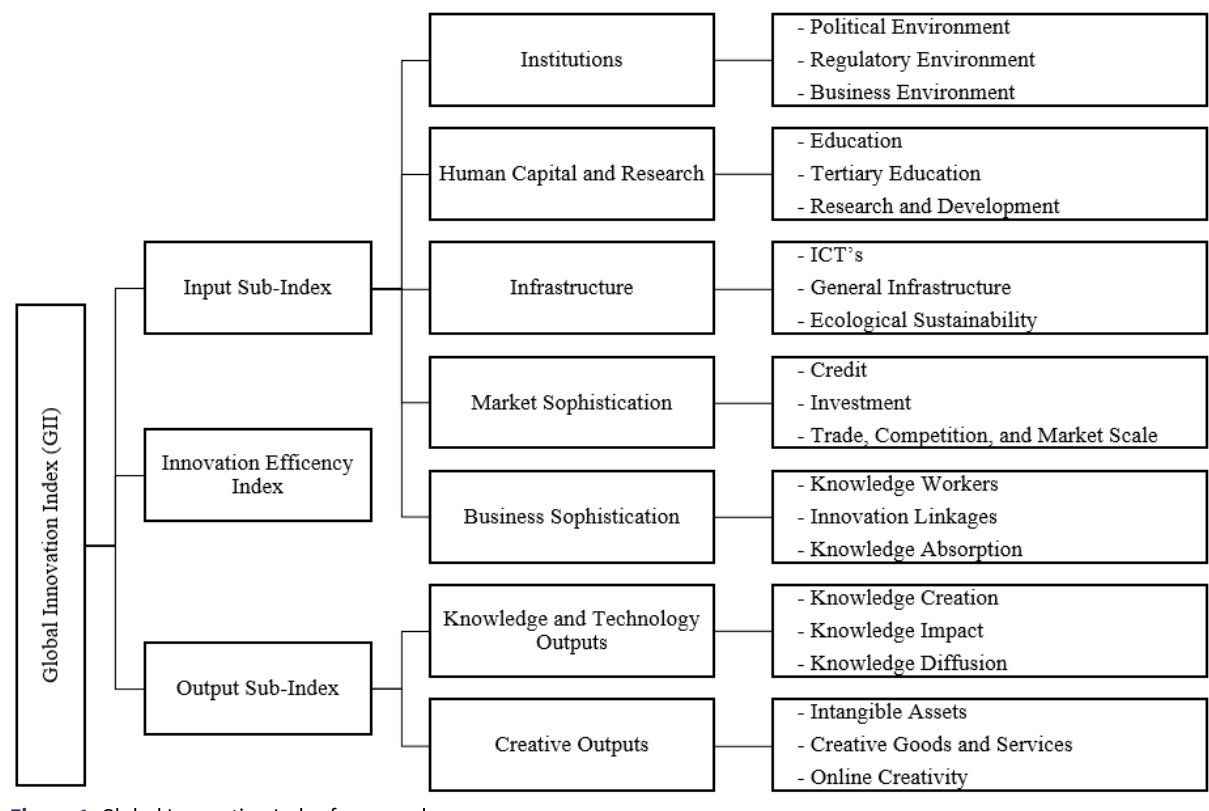
Figure 1. Global Innovation Index